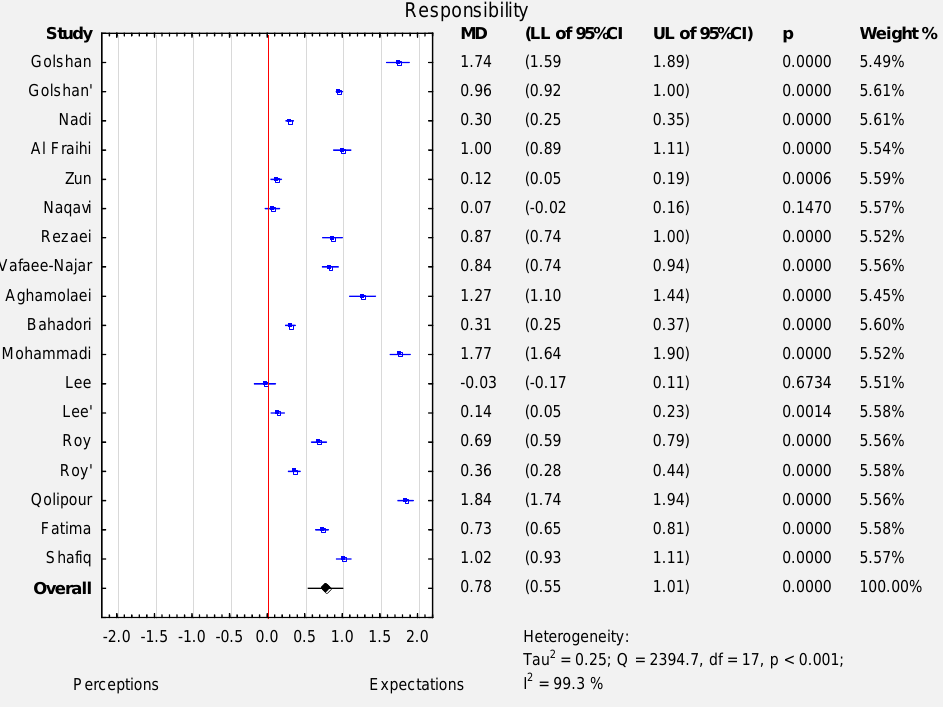
Figure 4. Forest plot for the mean difference ([MD]; 95% CI) of patients’ perceptions and expectations in the responsiveness dimension. According to the random effect meta-analysis (I-squared index 99.0%, p < 0.001), the pooled estimate of MD was 0.80 (95% CI: 0.63 – 0.98), which indicated that the expectations of all the participants were significantly higher than their perceptions ( p < 0.001) in the assurance dimension. The MD varied from 0.08 (Lee et al. [12]-patients) to 1.50 (Qolipour et al. [9]) (see Figure 5). The funnel plot (Supplementary Materials) and the results of Eg- ger’s test indicate no evidence of publication bias in some of the studies (t = 3.78, p = 0.01).